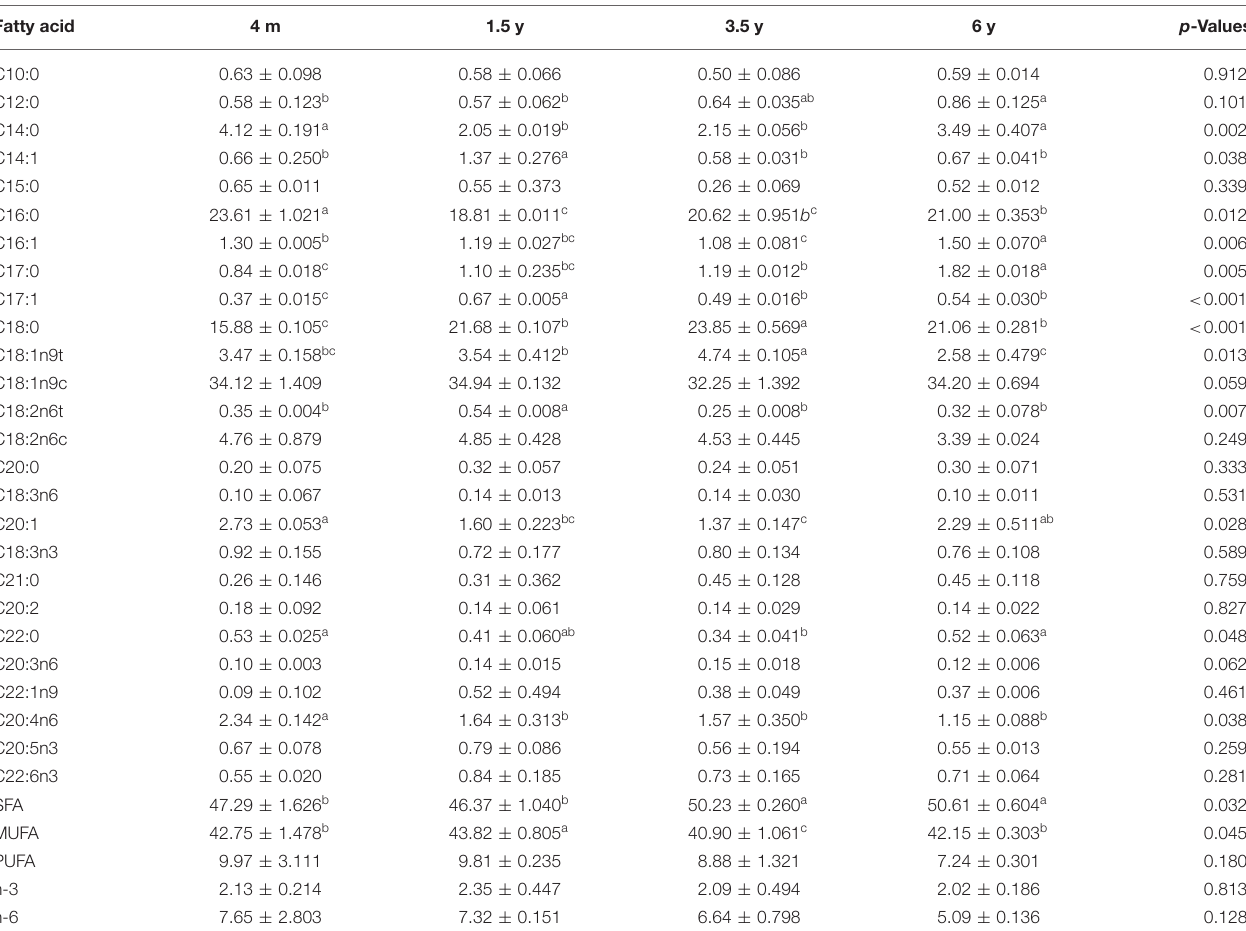
TABLE 3 | Effect of slaughter age on the fatty acid profile of LT muscle of Tibetan sheep (g/100g). Fatty